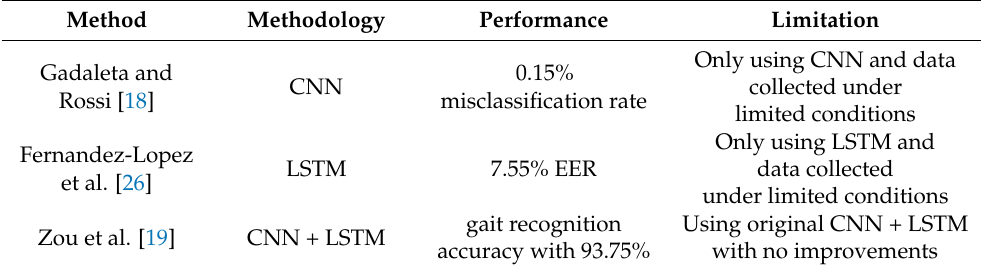
Table 2. The summary of the deep learning studies for gait recognition. Method Methodology Performance